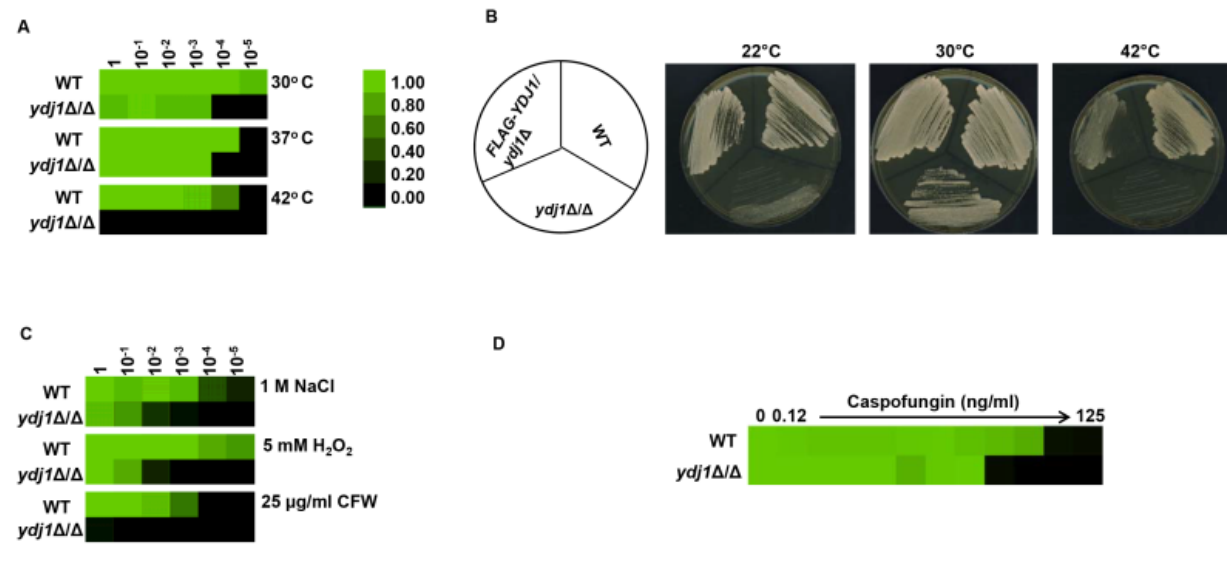
FIGURE 1: Ydj1 is required for stress resistance. (A) Ydj1 is required for thermal adaptation. Temperature sensitivity was assayed by moni- toring the growth of C. albicans wild-type (WT) and ydj1 Δ/ ydj1 Δ mutant cells at 30°C, 37°C, and 42°C. Cells were diluted 10-fold in YPD medium and grown statically at the indicated temperatures for 72 hours. Growth, measured by absorbance at 600 nm, was averaged for duplicate measurements and normalised relative to the undiluted wild-type strain (see colour bar). (B) Fitness and temperature sensitivity of the wild-type strain, the ydj1 Δ/ ydj1 Δ mutant, and the FLAG- YDJ1 / ydj1 Δ complemented strain. Strains were streaked onto YPD plates as diagrammed, and incubated at either 22°C, 30°C or 42°C for 48 hours. (C) Ydj1 is important for stress adaptation. Wild-type (WT) and ydj1 Δ/ ydj1 Δ mutant cells were diluted 10-fold in YPD medium supplemented with 1 M NaCl, 5 mM H 2 O 2 , or 25 µg/ml calcofluor white (CFW), and incubated statically at 30°C for 48 hours. Growth, measured by absorbance at 600 nm, was averaged for duplicate measure- ments and normalised relative to the undiluted WT strain. (D) Ydj1 potentiates caspofungin tolerance. MICs were performed in YPD medi- um with a caspofungin gradient from 0 to 125 ng/ml, in two-fold dilutions at 30°C. Growth, measured by absorbance at 600 nm, was aver- aged for duplicate measurements and normalised relative to the undiluted WT